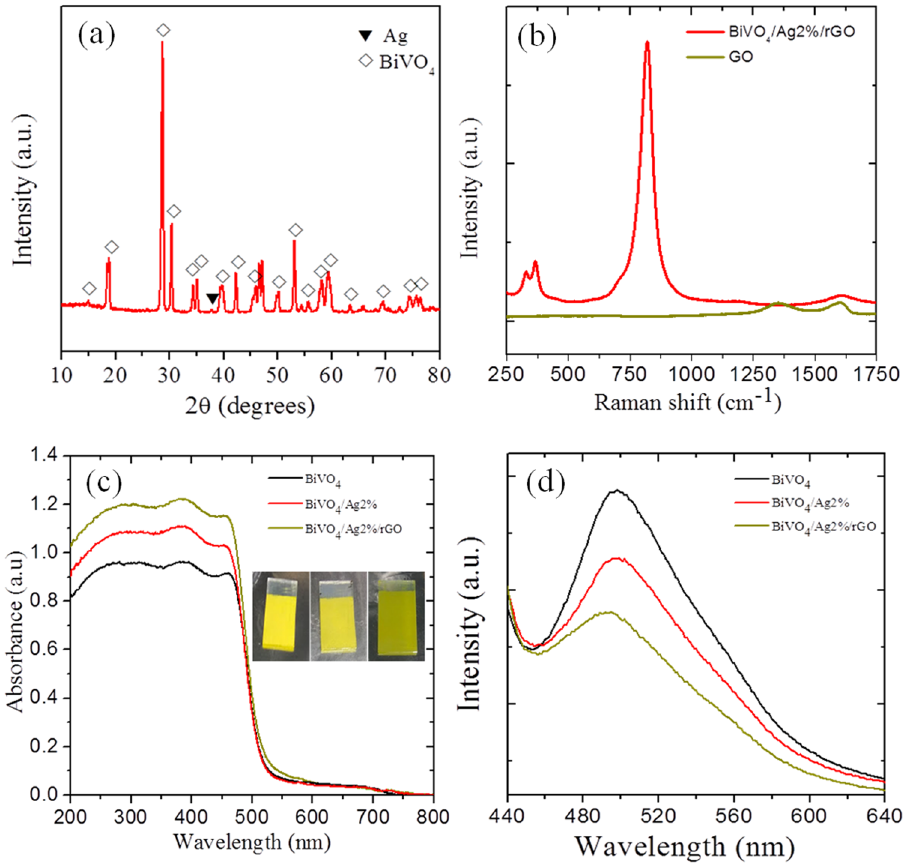
Figure 1. ( a ) XRD pattern of the BiVO 4 /Ag2%/rGO sample. ( b ) Raman spectra of graphene oxide (GO) and the BiVO 4 /Ag2%/rGO sample. ( c ) UV-Vis absorption spectra of various samples. Inset shows the photographs of the BiVO 4 , BiVO 4 /Ag2%, and BiVO 4 /Ag2%/rGO samples. ( d ) PL spectra of various